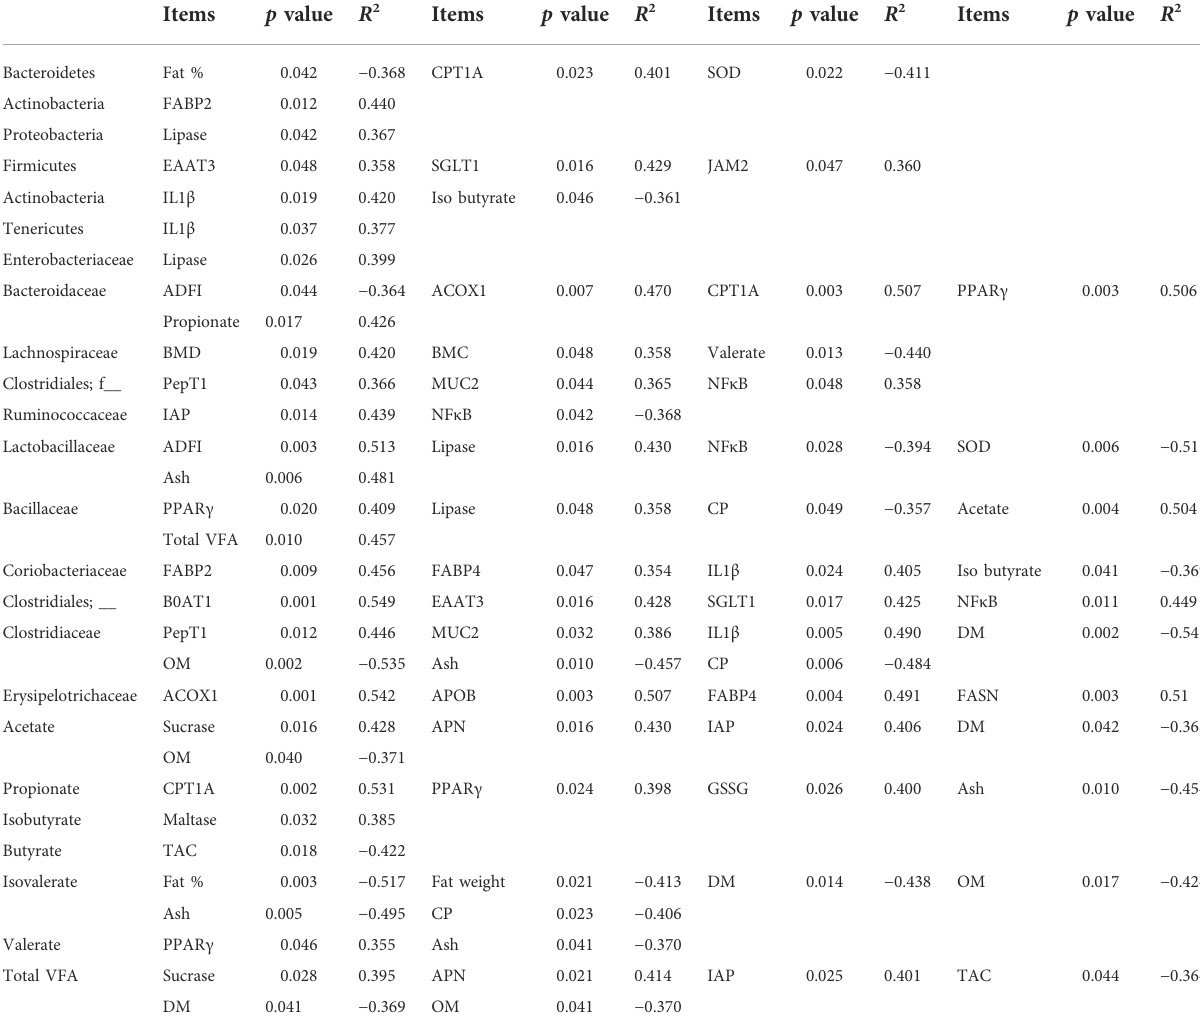
TABLE3Correlationbetweenthececalmicrobialcompositionwithvolatilefattyacidsandgrowthperformance(ADFI),fataccumulation(fat%),bone health (BMC and BMD), fat metabolism mRNA expression (ACOX1, APOB, CPT1A, FABP2, FABP4, FASN, and PPAR γ ), immune system (IL1 β ), gut barrier integrity (JAM2 and MUC2), brush border digestive enzymes (APN, Lipase, Sucrase, Maltase, and IAP), antioxidant capacity (TAC and SOD), apparent ileal digestibility (DM, OM, and CP), nutrient transporters (EAAT3, B0AT1, SGLT1, and PepT1), and volatile fatty acid production parameters (acetate, propionate, and isobutyrate) with signi fi cant differences ( p < 0.05) in broilers fed different concentration of tannic acid on D